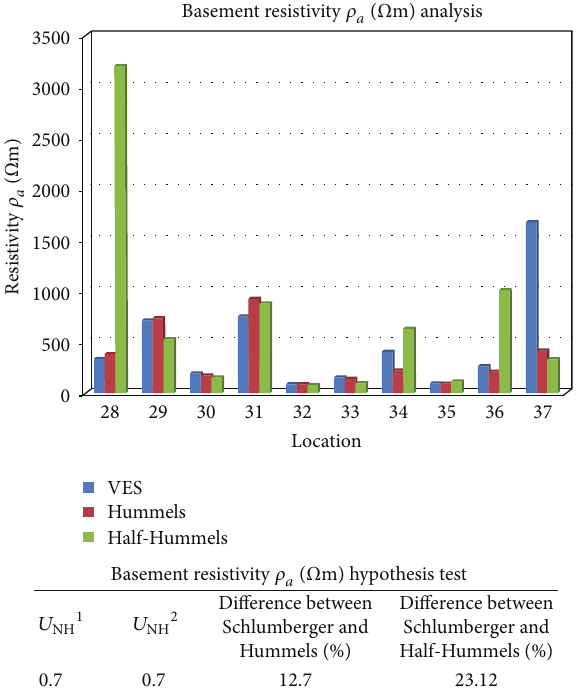
Figure 8: Bar chart and statistical test of hypothesis table for the different array methods comparing basement resistivity for locations on quartz schist.